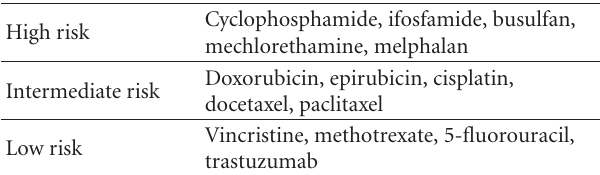
Table 1: Risk of ovarian toxicity of antineoplastic drugs.